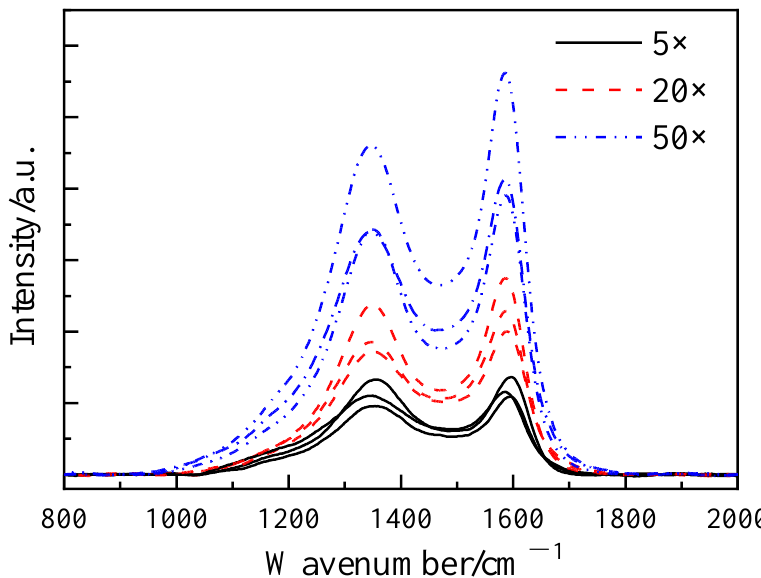
Figure 3. Raman peak intensity for char1 with a particle size of 61 – 75 μm for different objective lens magnifications.